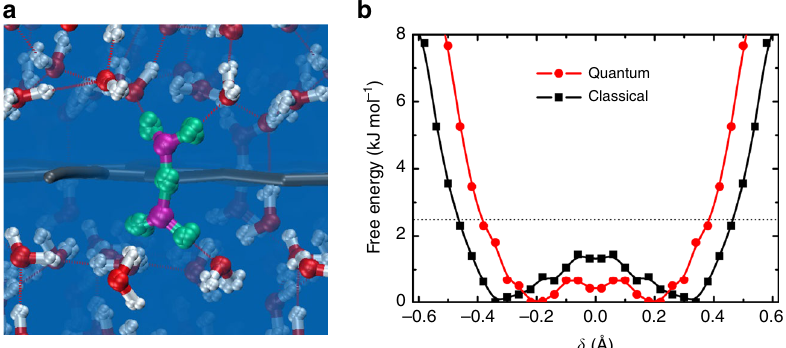
Fig. 5 Trans-membrane (TM) proton transport driven by electric fi eld. a Typical quantum con fi guration of TM H 5 O 2 + complex in path-integral molecular dynamics (PIMD) simulations. b The free energy pro fi le of the excess proton during proton transport processes from classical and quantum nuclei simulations under electric fi eld, respectively. The pro fi les are symmetrized for a more accurate quanti fi cation of the barrier. The thermal energy k B T at 300 K is denoted by the horizontal dashed